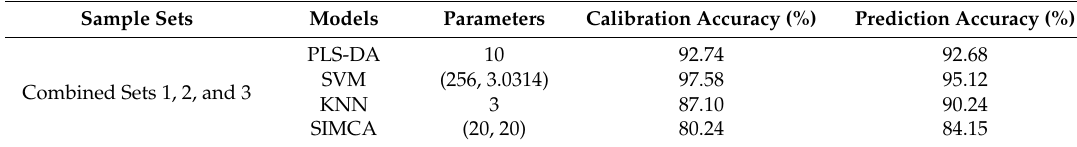
Table 6. The results of the different calibration models using combined sample